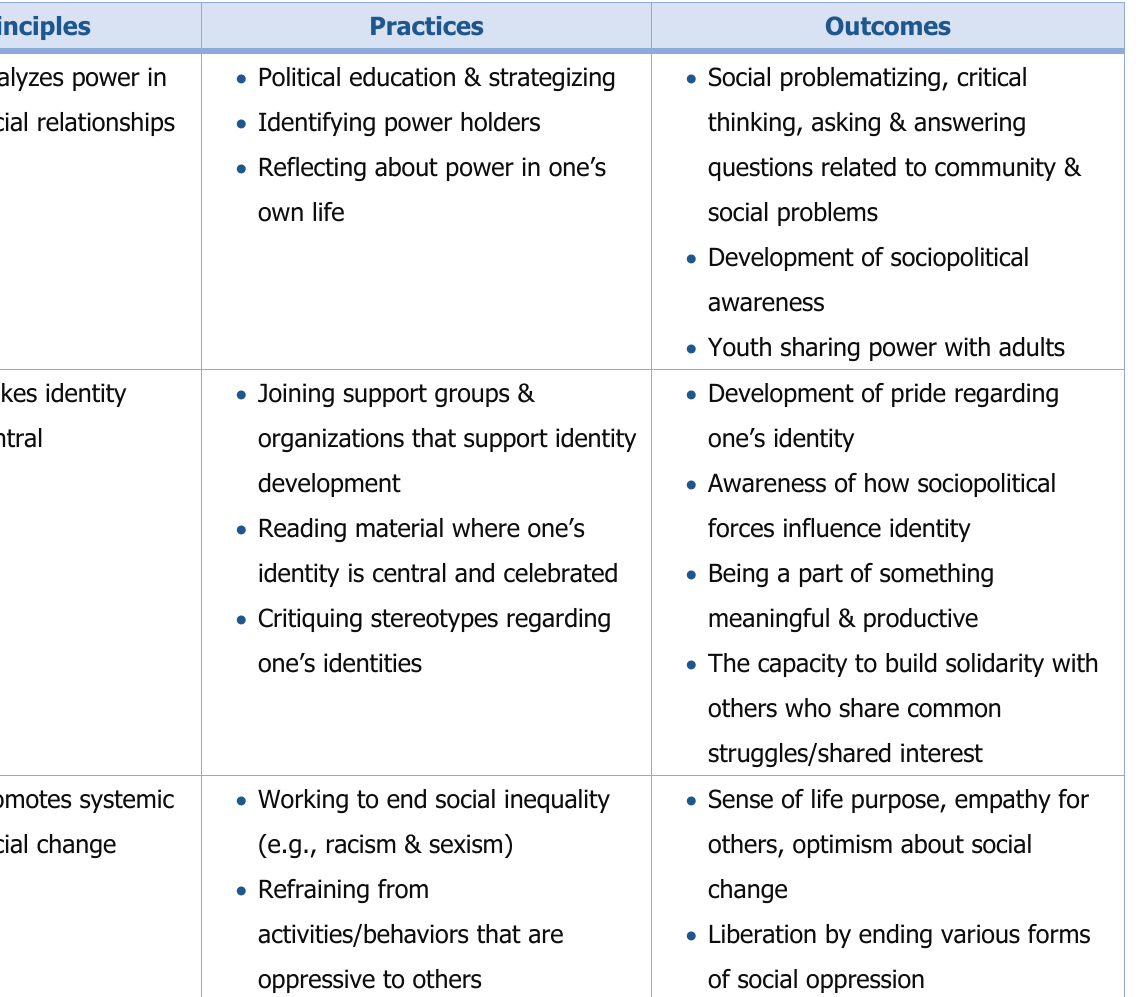
Table 1. Social Justice Youth Development Framework (Ginwright & Cammarota, 2002; Fields et al.,